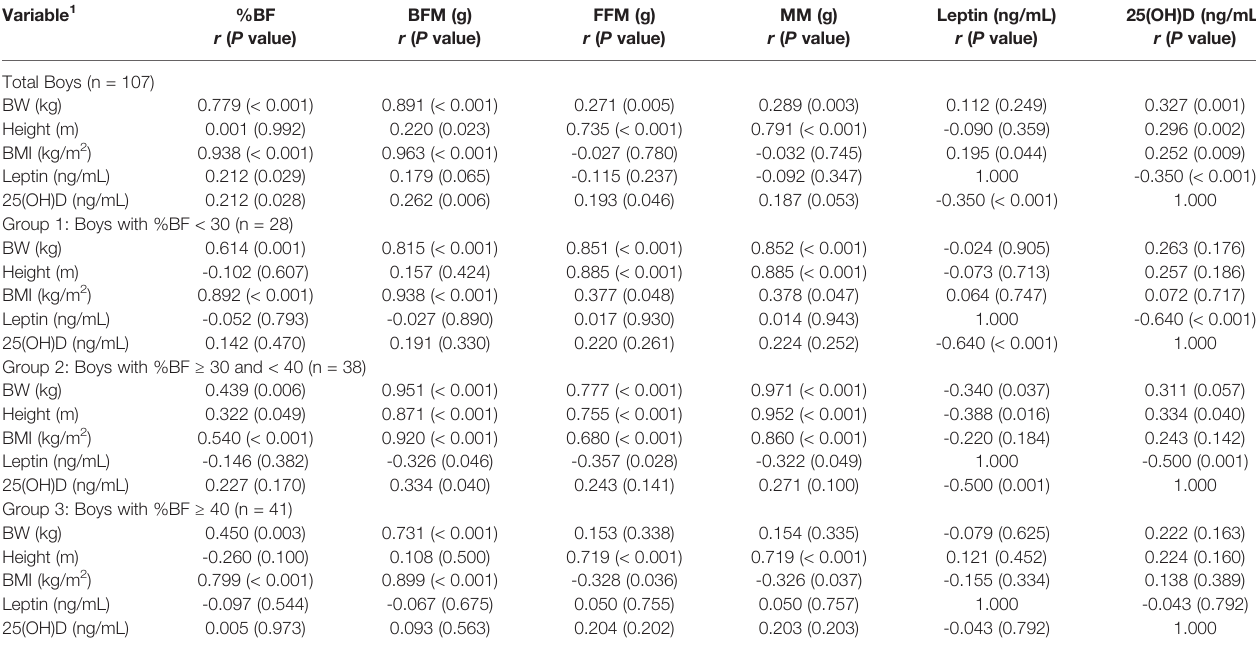
TABLE 3 | Correlation coef fi cient, r ( P value), between BMI parameters, body composition, leptin, and 25(OH)D in boys. Variable